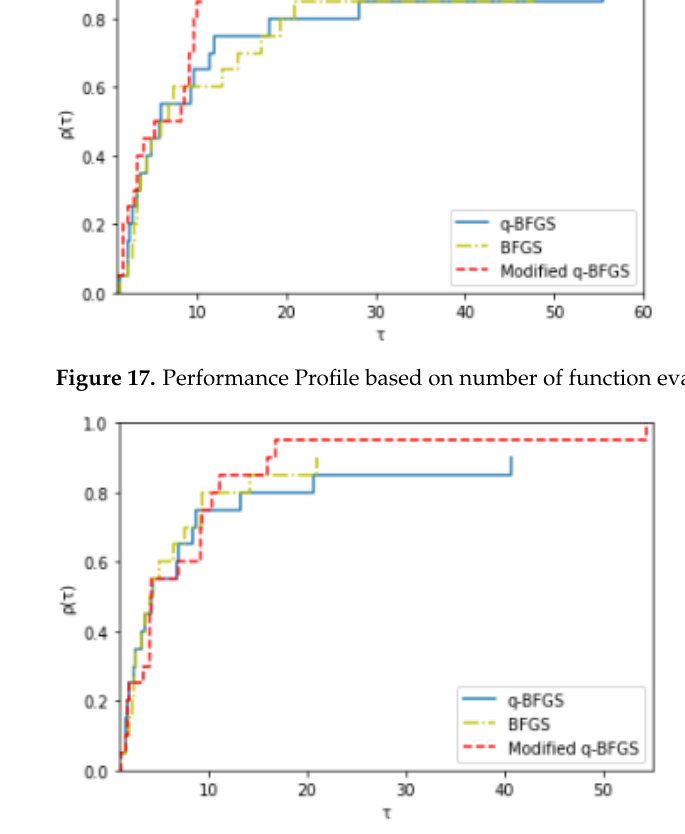
Figure 18. Performance Profile based on number of gradient